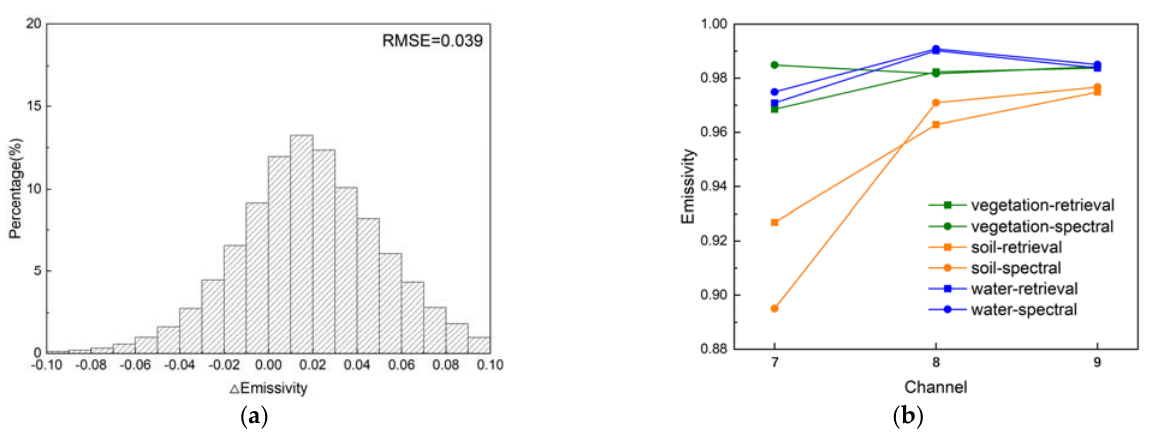
Figure 6. The validation results of the retrieval image. ( a ) The emissivity residual histogram; and ( b ) comparison of emissivity spectral shape.